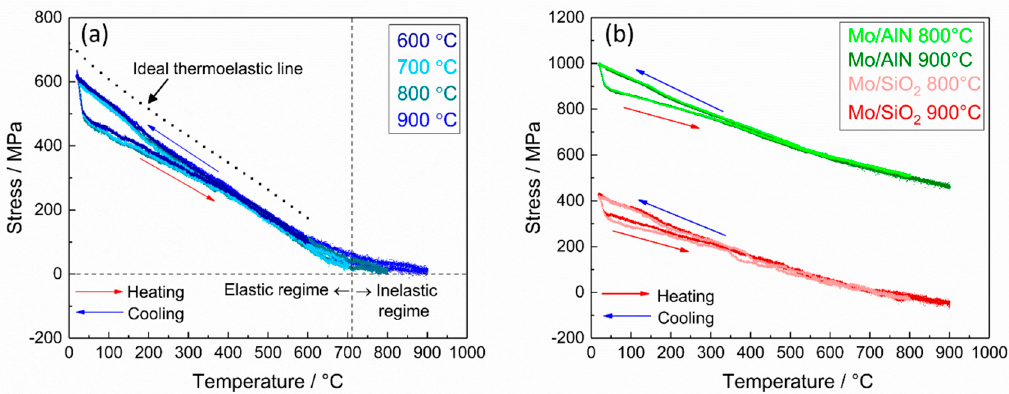
Figure 4. Stress as a function of temperature measured on the Mo films during the thermal cycles after preannealing: ( a ) uncovered Mo film and ( b ) covered Mo film with AlN or SiO 2 .